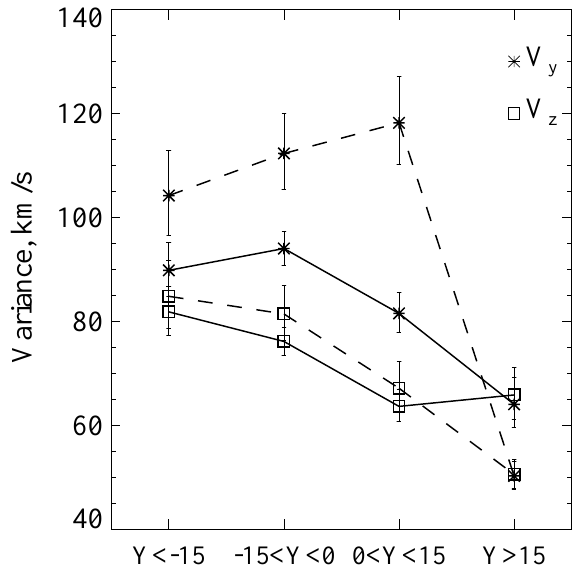
Fig. 4. Variances of V y (stars) and V z (squares) flows in the in- ner (dashed curves) and the outer (solid curves) plasma sheet with respect to the Y GSM spacecraft